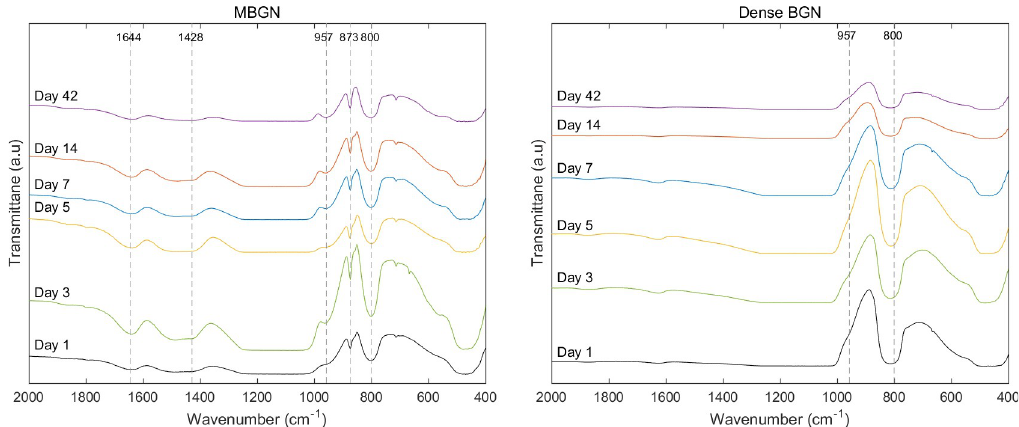
Fig 9. FT-IR patterns of (a) MBGN and (b) Dense BGN at 1, 3, 5, 7, 14, 42 days after soaking in simulated body fluid (SBF) solution.